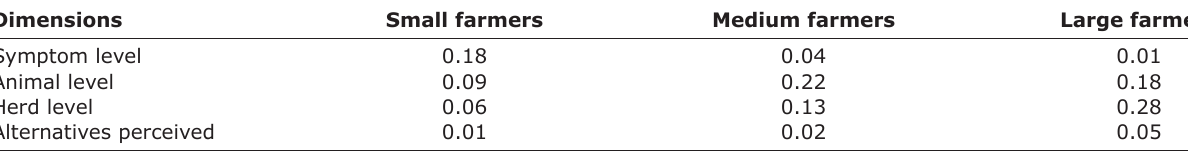
Table-5: Distribution of dairy farmers with respect to antibiotic usage practices. Dimensions